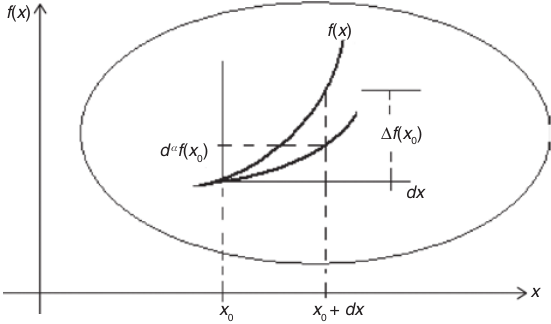
Figure 1: The non-linear differential of f ( x